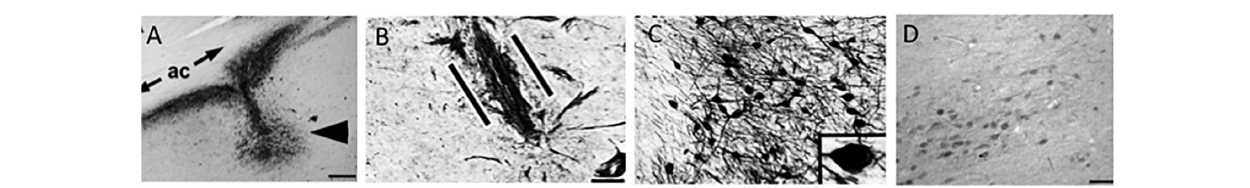
FIGURE 11 | (A) Nerve growth factor (NGF) immunolabeling shows the site of NGF gene delivery in the human nucleus basalis of Meynert (arrowhead) under the anterior commissure (ac). Scale bar = 325 µ m. The patient received the injection 3 years previously. (B) p75 NTR neurotrophin receptor immunolabeling shows basal forebrain cholinergic axons penetrating into the graft (between the parallel lines) in a linear fashion. Scale bar = 25 µ m. (C) Nerve growth-factor-expressing neurons compared with less intense labeling in the nucleus basalis of Meynert neurons located 3 mm from the injection site (D) . Scale bar in (C) = 100 µ m and in (D) = 325 µ m. Images reproduced from Tuszynski et al.